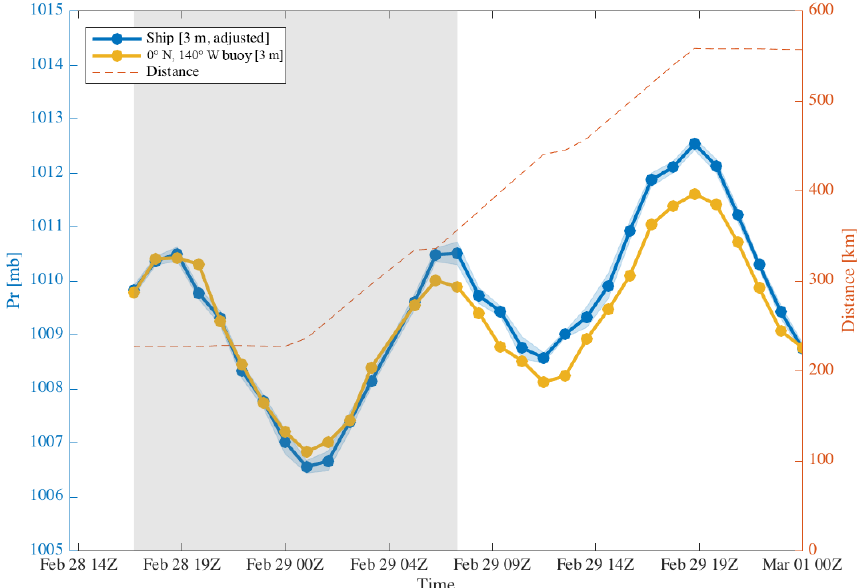
Figure 13. Barometric pressure at 3ma.s.l. from the ship (blue) and from buoy dm166b (yellow), 28 February through 1 March 2016. Each observation is a 2min average centered on the top of the hour. Blue shading shows the 1 σ variability of the 2min average from the ship; this information is not available from the buoy. The red-dashed line shows the distance between the ship and the buoy in kilometers. For the time period when the ship was < 350km from the buoy (grey shading), the difference (ship minus buoy) is − 0.03 ±